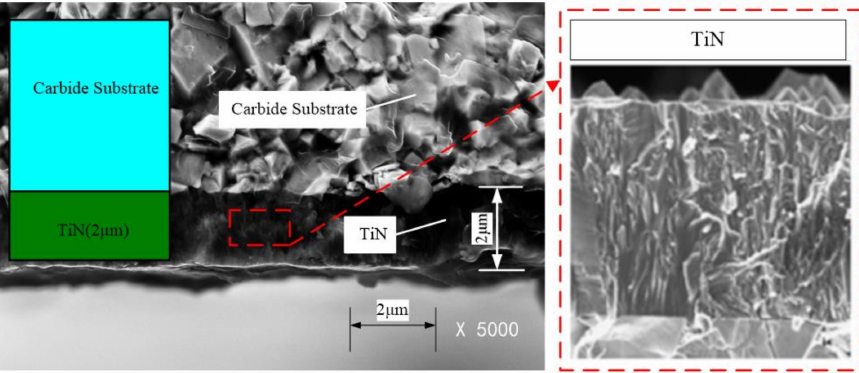
Figure 4. Structure of carbide substrate and components of KT315 coated cutting tool. Magnification: 5000 × .